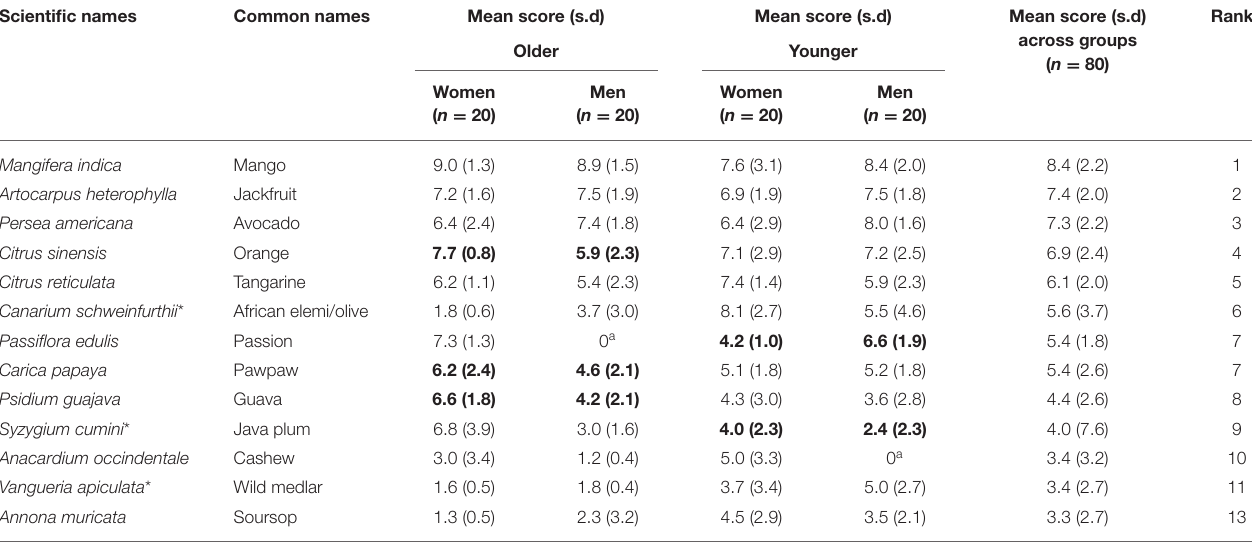
TABLE 3 | Score ranking of the 10 most preferred food trees according to different gender and age groups in Nakaseke and Nakasongola districts of